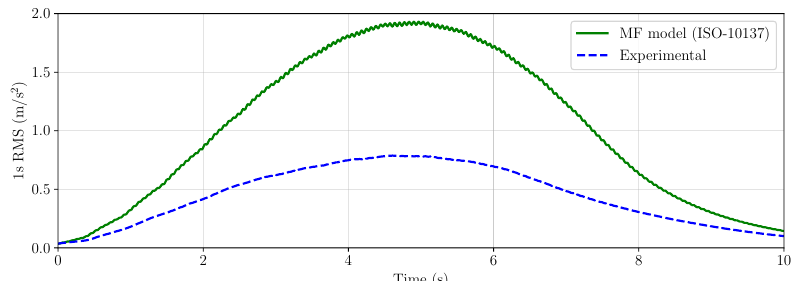
Figure 9. Comparison of 1s RMS acceleration using a non-interacting MF